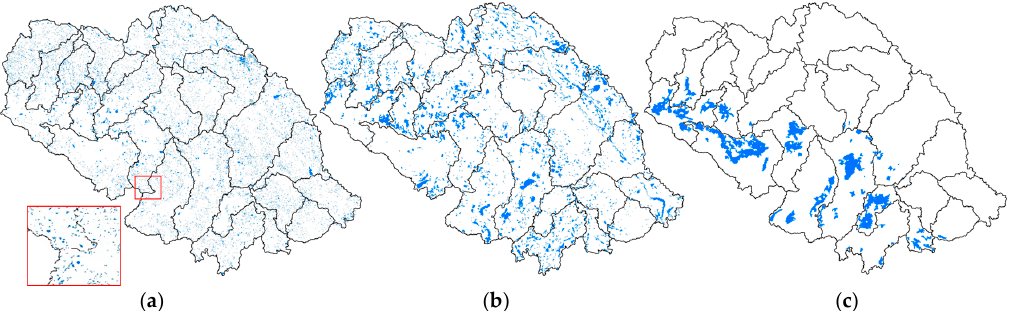
Figure 3. Spatial distributions of puddles classified based on their mean depths (MD): ( a ) small depressions: 0 cm ≤ MD < 5 cm; ( b ) medium depressions: 5 cm ≤ MD < 2 m; and ( c ) large depressions: MD ≥ 2 m. Table 2. Characteristics of depressions classified by their mean depths (MD): medium depressions: 5 cm ≤ MD < 2 m and large depressions: MD ≥ 2 m.